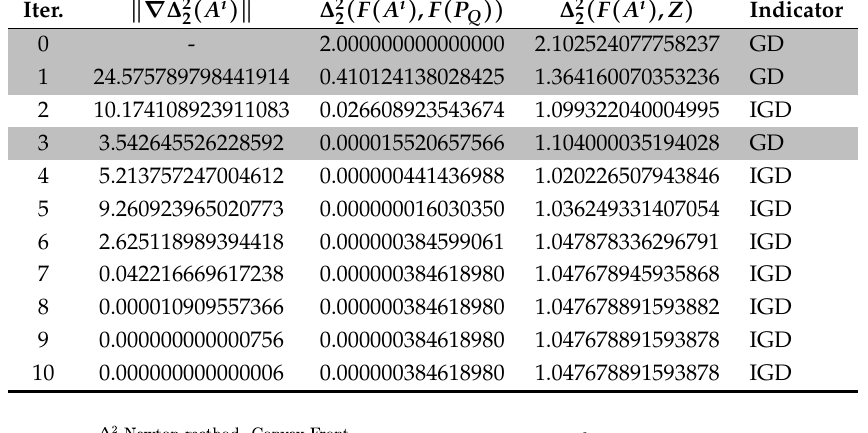
Table 5. Numerical results of the ∆ 2 Iter.